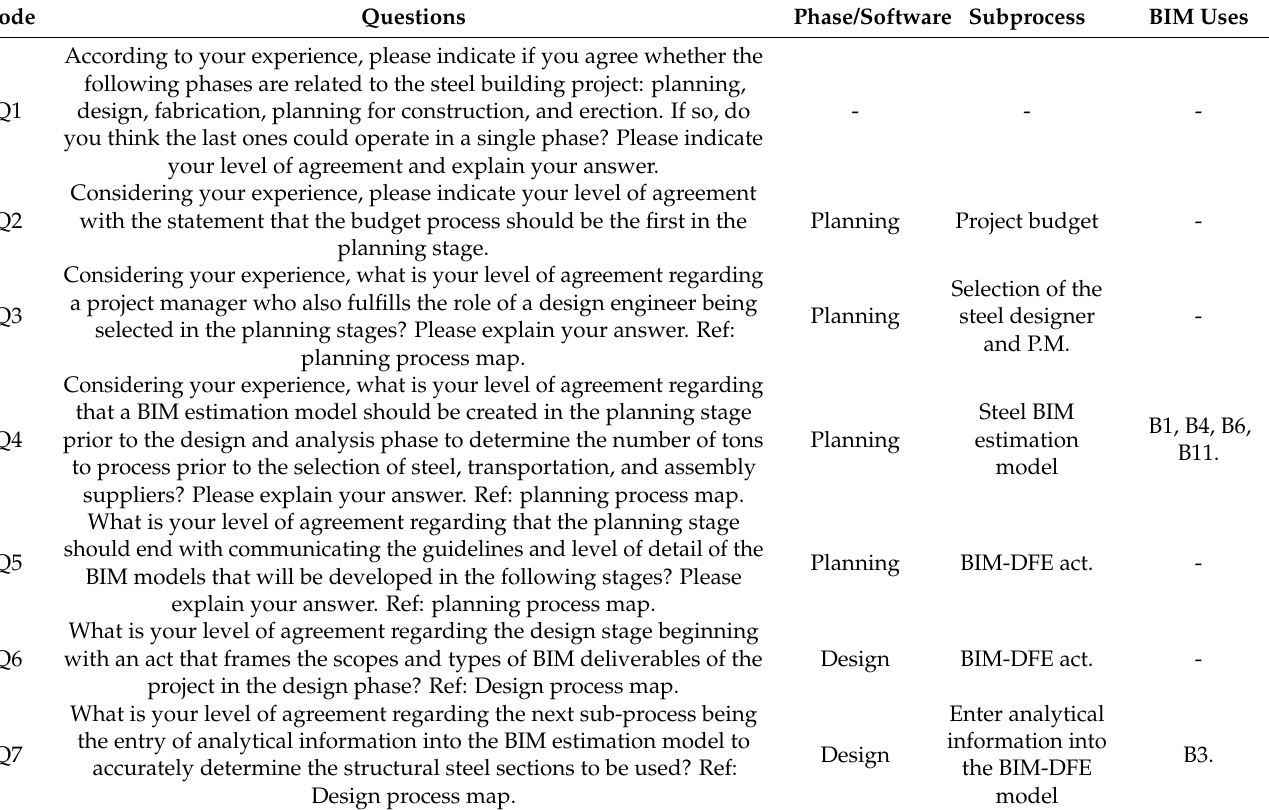
Table A1. Questions for the First